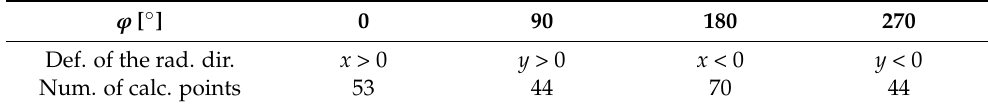
Table 1. Numeric grid for invariant maps.